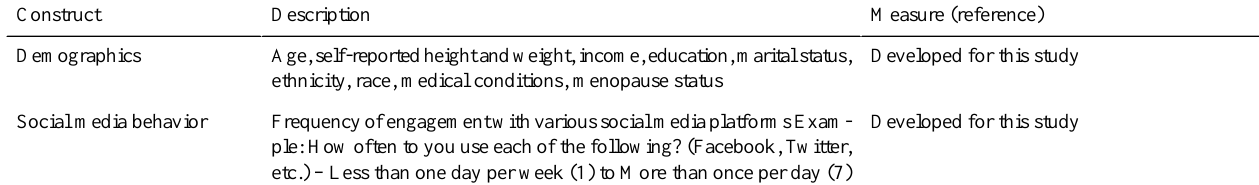
Table 1. Baseline measures.